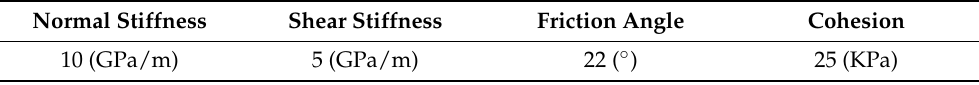
Figure 5. Model geometry used for numerical modelling of the landslide, highlighting gradual river erosion characterized by sequential removal of rock blocks, thrust faulting of a bedding plane, and the location of 3 history points (H1, H2 and H3). Table 3. The property of discontinuities used in numerical modelling.